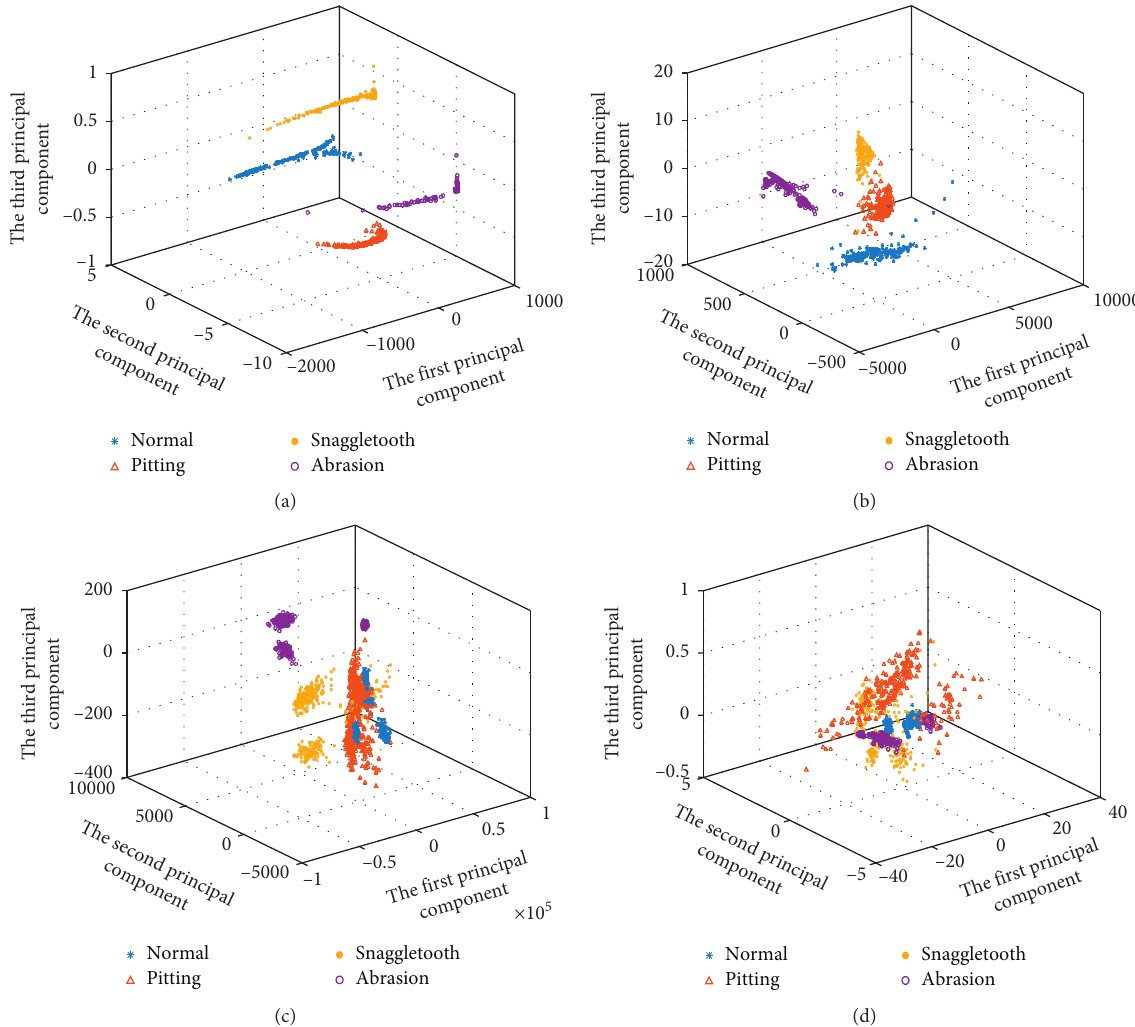
Figure 9: Visual scatter diagram of feature extraction. (a) The proposed method. (b) DBN set by experience. (c) Shallow probability network. (d) Traditional feature extraction